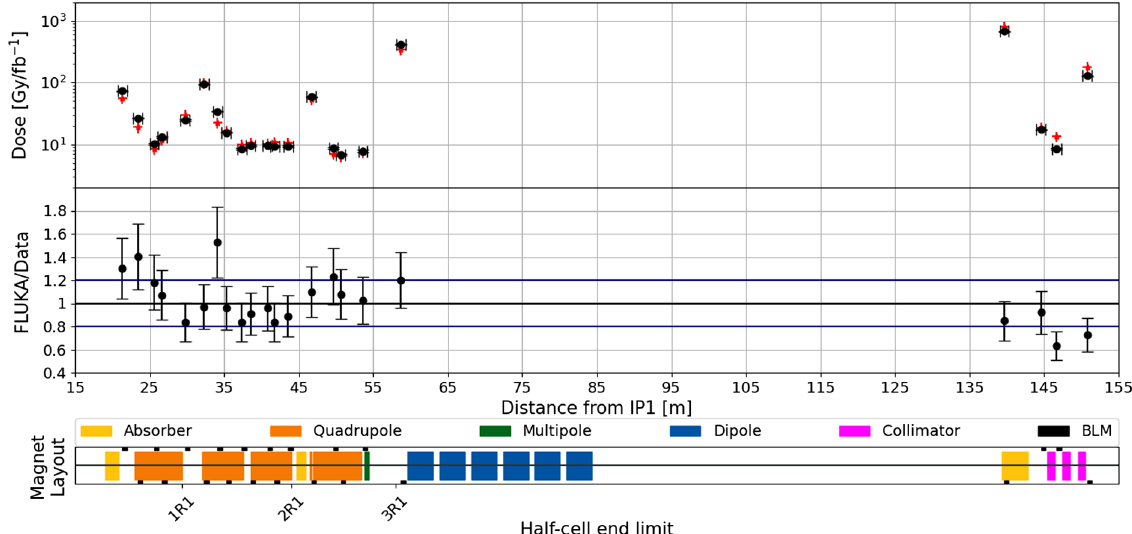
FIG. 4. Top panel: Beam loss monitor (BLM) pattern along the ATLAS insertion as measured over a 2018 13 TeV center-of-mass p þ p run period yielding 20 . 3 fb − 1 (red crosses) and calculated by FLUKA (black circles). Mid panel: Ratio between simulation values and data. Vertical bars correspond to a 20% uncertainty on data. Bottom panel: Machine layout.